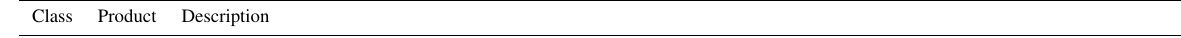
Table A2. Detailed description of each LULC class used to build the legend for TimeSpec4LULC dataset. NU: not used. NA: not